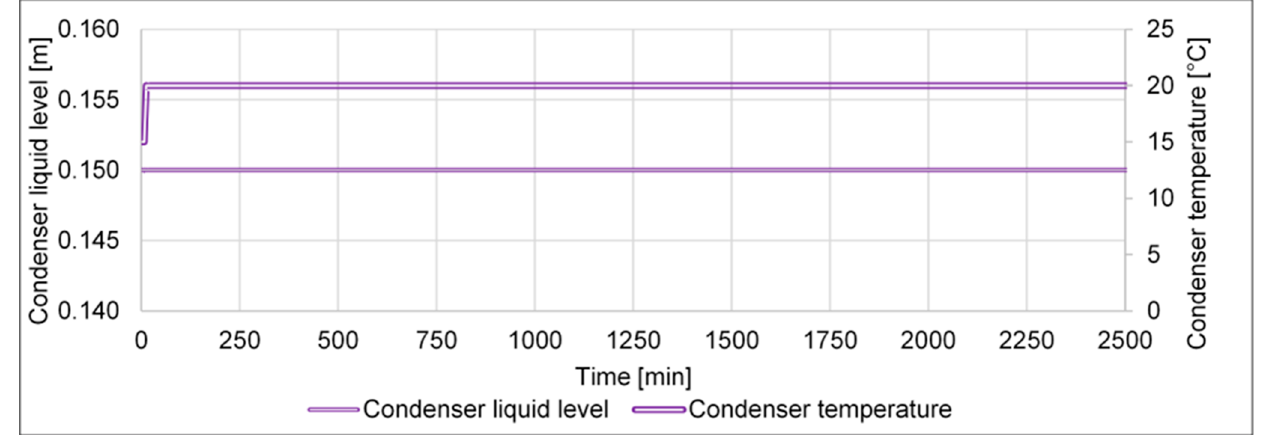
Figure 17 . Condenser liquid level and position of the recycle valve (left and right vertical axis) of scenario (g).